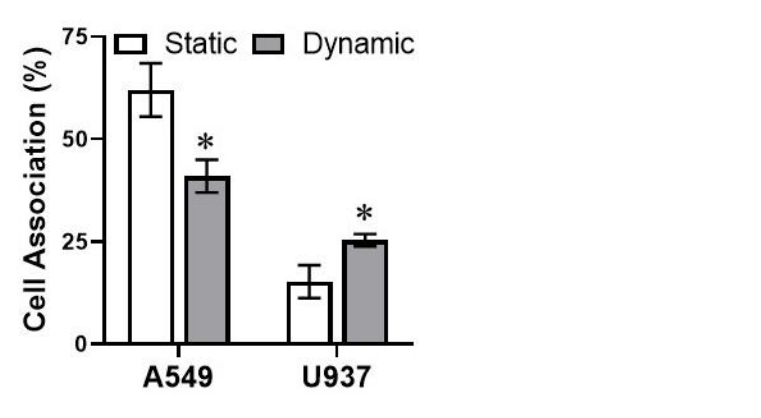
Figure 2. AgNP cellular association varies as a function of flow environment and cell model. Fol- lowing 24 h exposure, AgNP interactions with the adherent A549 or suspension U937 models were measured within both static and dynamic environments. * indicates significance between static and dynamic conditions. n = 3, p < 0.05.